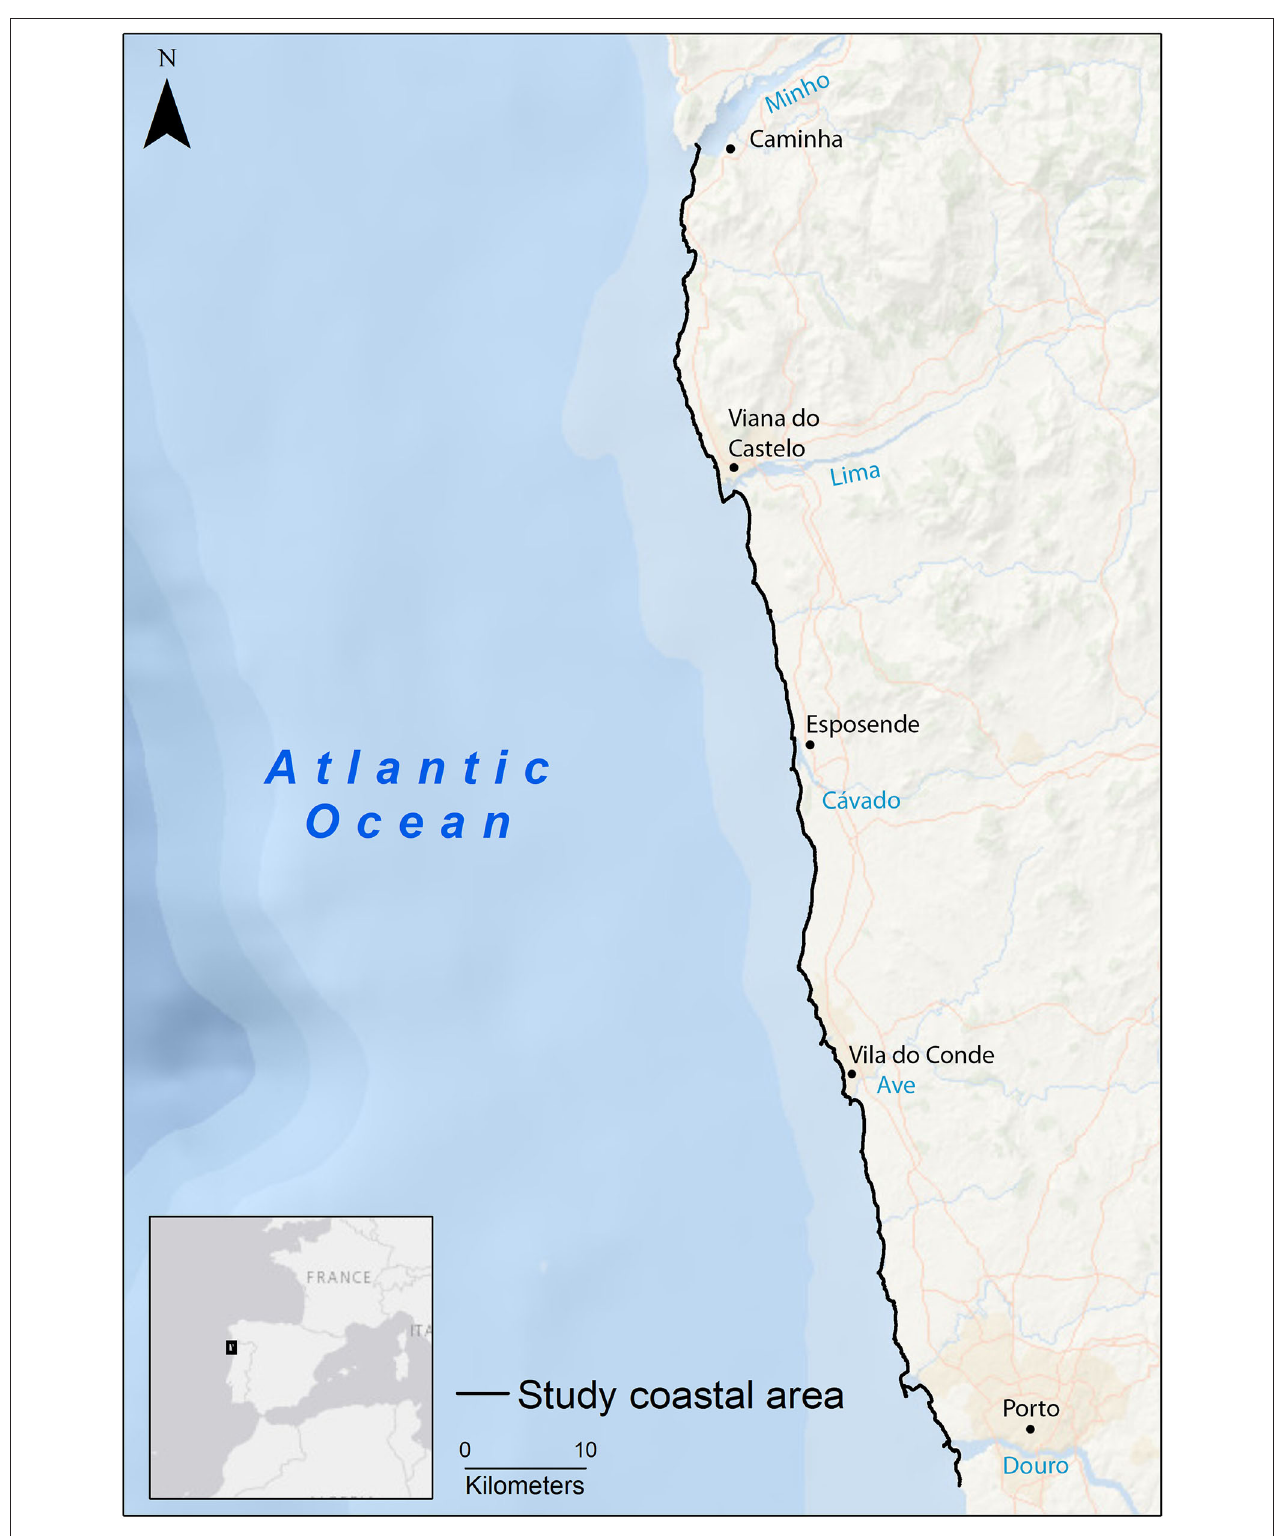
FIGURE 1 | Location of the study area on the northern coast of Portugal.